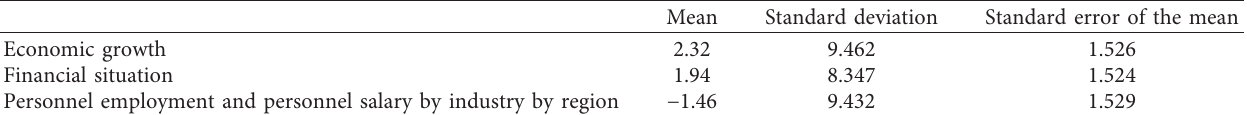
Figure 9: Research and analysis diagram of railway traffic index data separately based on MMD algorithm. Table 11: Analysis table of the result analysis of the risk assessment system of Yebes algorithm.